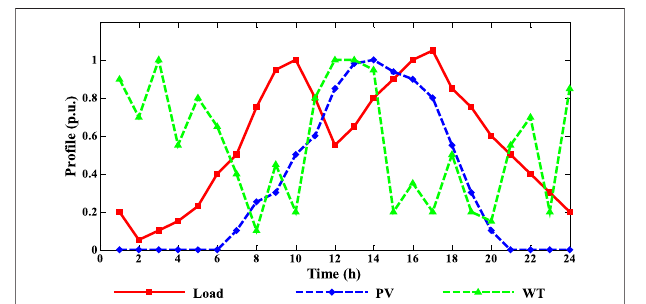
FIGURE 7 | Time sequence fl uctuation of load and DG.